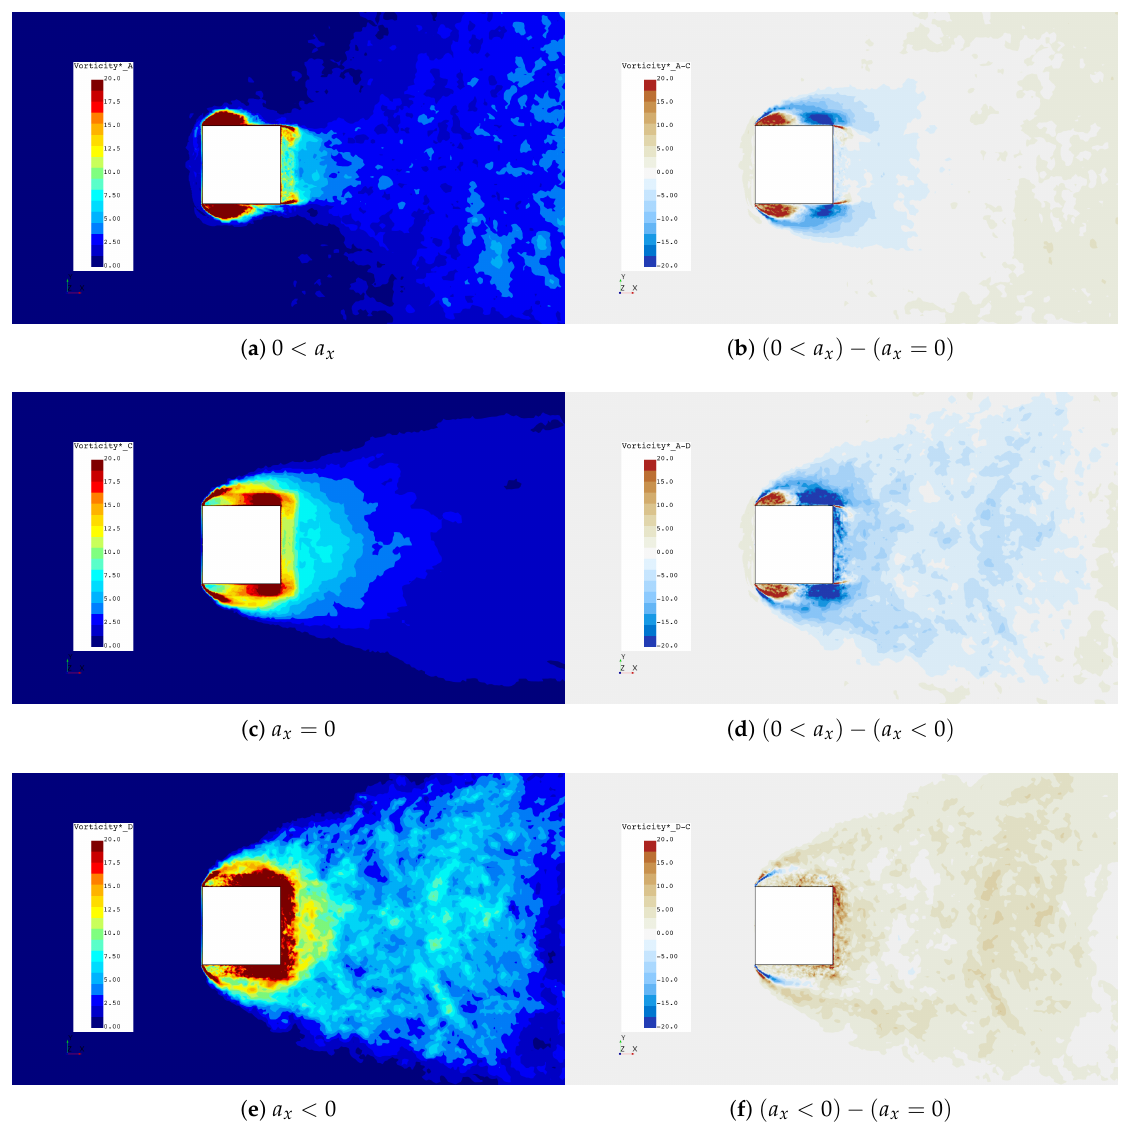
Figure 16. | ω ∗ | scalars and deltas at cylinder center